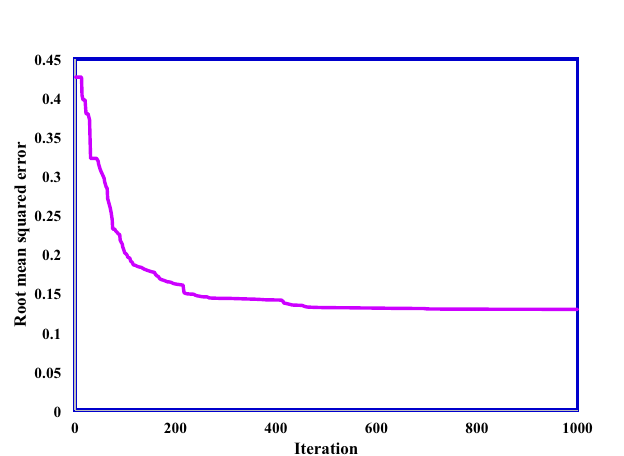
Figure 5. Relevance factor of different input variables.